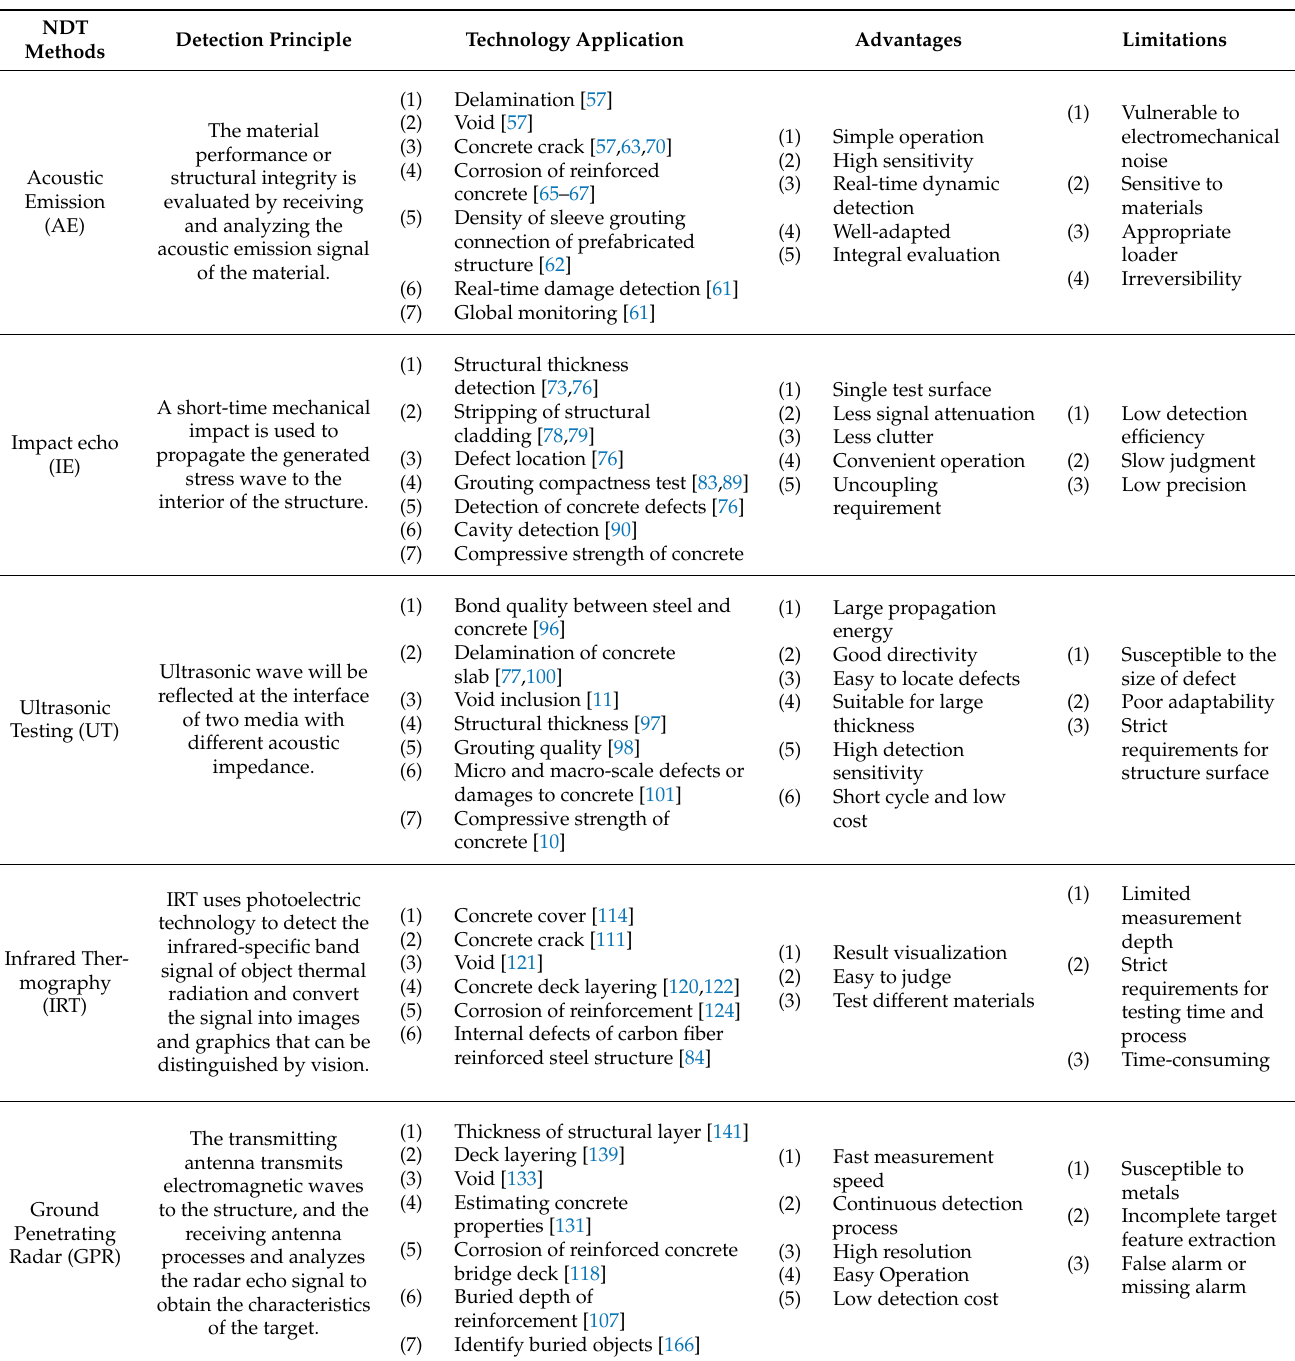
Table 1. Advantages and limitations of various NDT